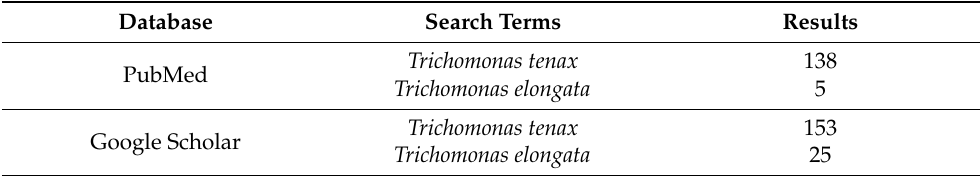
Table 1. Results obtained from search strategies used in databases.